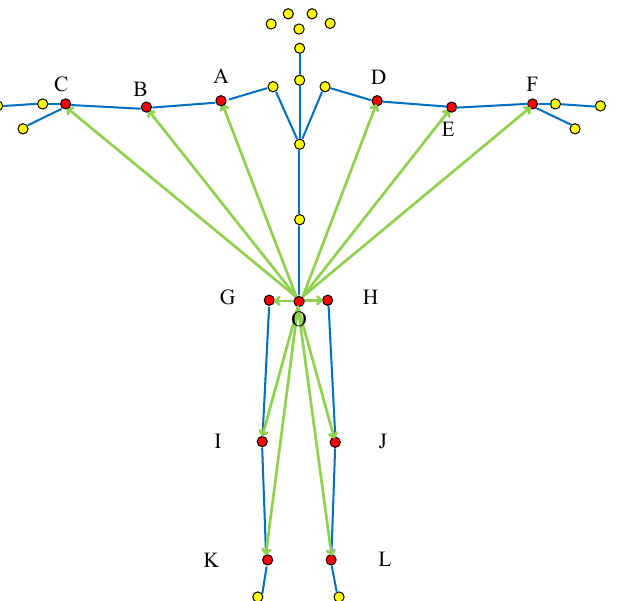
Figure 4. Overall “pelvis divergence method” vector selection (The red dots are the selected bone joint, and yellow dots are bone joint points that do not need to be selected. Green lines are selected joints, blue lines are not selected joints. The letters correspond to Table 1 and Figure 1.).